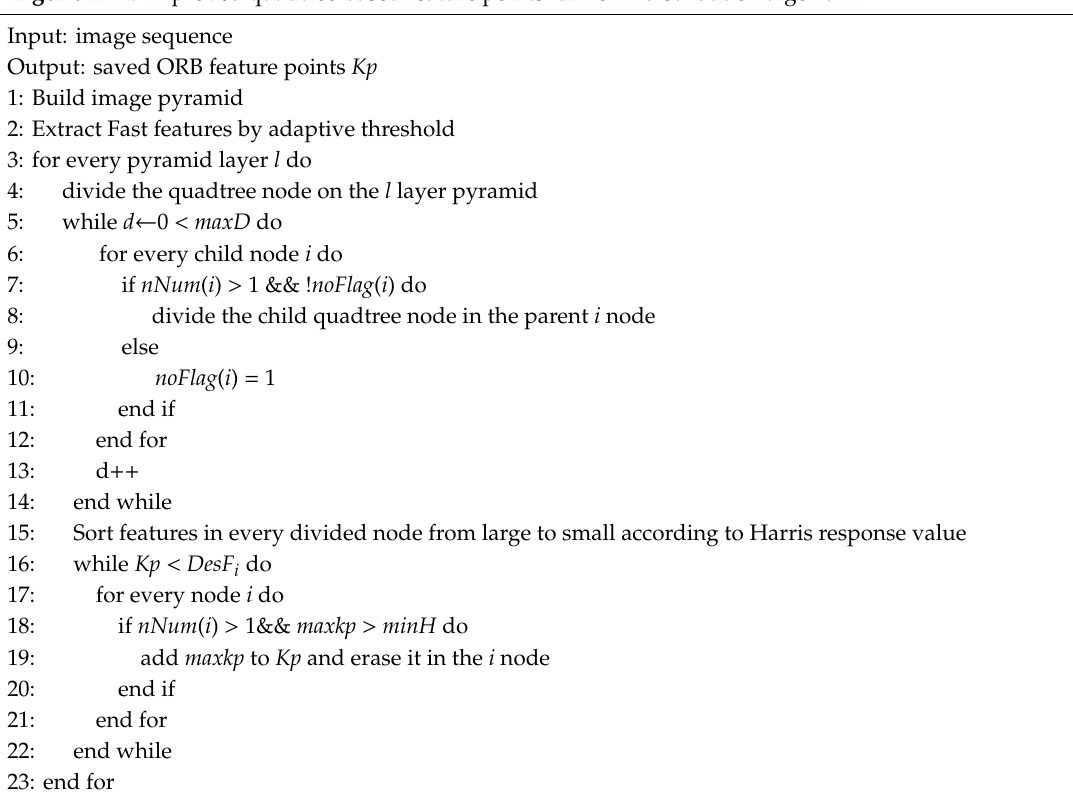
Algorithm 1. Improved quadtree-based feature points’ uniform distribution